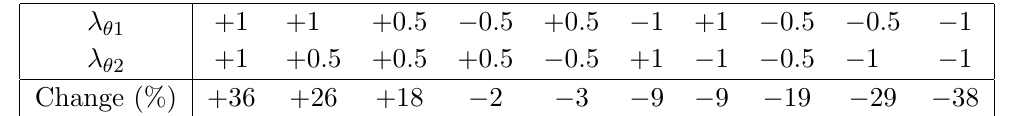
Table 2 . Relative change in percent of the acceptance-corrected (cid:7)(1S)(cid:7)(1S) yield for di(cid:11)erent polarization assumptions with respect to that for (cid:21) (cid:18) 1 = (cid:21) (cid:18) 2 = 0. parameter [41]. The extreme cases (cid:21) (cid:7)(1S) meson decay or 100% longitudinal (transverse) polarization. The polar anisotropic parameter for each (cid:7)(1S) candidate, labeled as (cid:21) table 2 shows a summary of this study. Compared to an isotropic (cid:7)(1S) meson decay, the corrected yield is 38% lower for (cid:21) variation is not included in the total systematic uncertainty, but is quoted